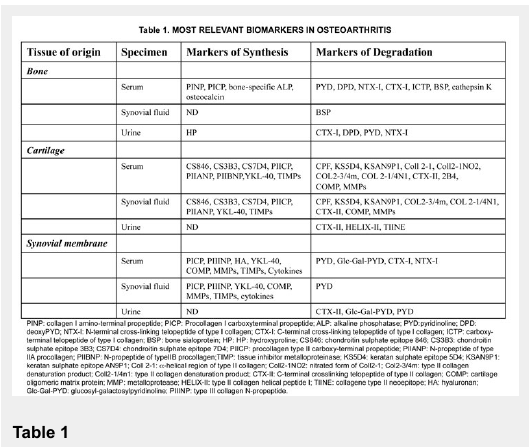
Chondrocyte changes induced by mechanical stress. Chondrocytes can respond to direct biomechanical perturbation by increasing expression of inflammatory mediators, including cytokines and proteinases, and stress response factors. Chondrocytes have receptors for responding to mechanical stimulation (mechanoreceptors), many of which are also receptors for extracellular matrix (ECM) components, including: integrins, a receptor for fibronectin and type II collagen fragments; discoidin domain receptor-2 (DDR-2), a receptor of native II collagen fibrils; annexin-V, a receptor of collagen II fragments. All these receptors interacts with intracellular signaling molecules to transduce mechanical signals into biochemical responses which lead to a production of number of proinflammatory substances, including cytokines, proteolytic enzymes, NO and PGE2. The most important among these intracellular signal cascades are NF-kB and MAPK pathways. The MAPK family, which include p38, Erk 1 and 2, and JNK, is of critical importance for cell survival, cell differentiation, and chondrogenesis. Other interesting ways stimulated by mechanical forces are the stretch-activated ion channels (SACs), which are believed to respond to membrane tension, interacting with integrins and leading to an elevation of intracellular calcium. This may stimulate mitochondria to release AIF and cytochrome c, which in turn activate pro-caspases 9 and 3 to produce caspase 9 and capsase 3, involved in chondrocyte apoptosis. To this process may also contributes calpains, a family of proteolytic enzymes stimulated by the rise in cytoplasmatic calcium from the ERG and